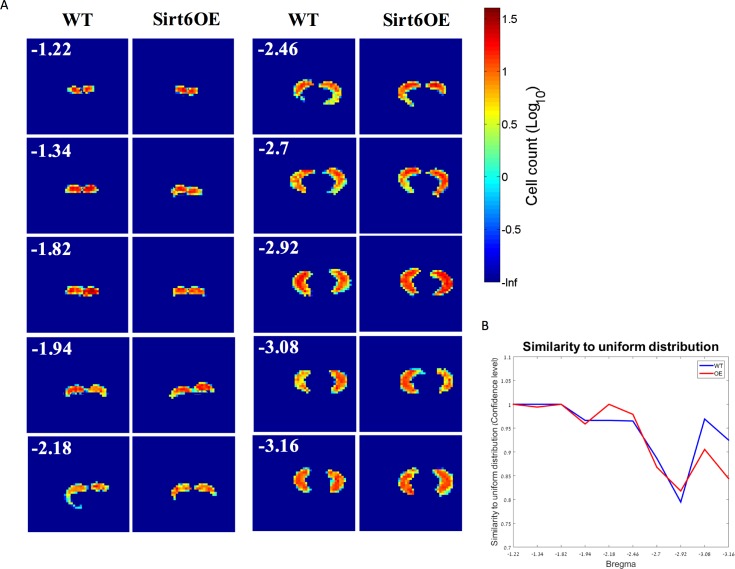
Sirt6-OE does not affect hippocampal distribution of astrocytes.Bivariate distribution of astrocytes scattering in the hippocampi of SIRT6 OE and WT mice. (A) Two dimensional scattering distributions of astrocytes in the following distances from bregma: -1.22, -1.34, -1.82, -1.94, -2.18, -2.46, -2.7, -2.92, -3.08, -3.16 of SIRT6 OE (n = 6) and WT (n = 6) hippocampi, logarithmic scale of cell count per square bin (bin size = 182 μm). (B) Similarity of astrocyte distributions to a hypothetical uniform distribution of the same size and shape in the two-dimensional space as a function of bregma, expressed as the confidence level (1—P value), two-sample Kolmogorov-Smirnov test.